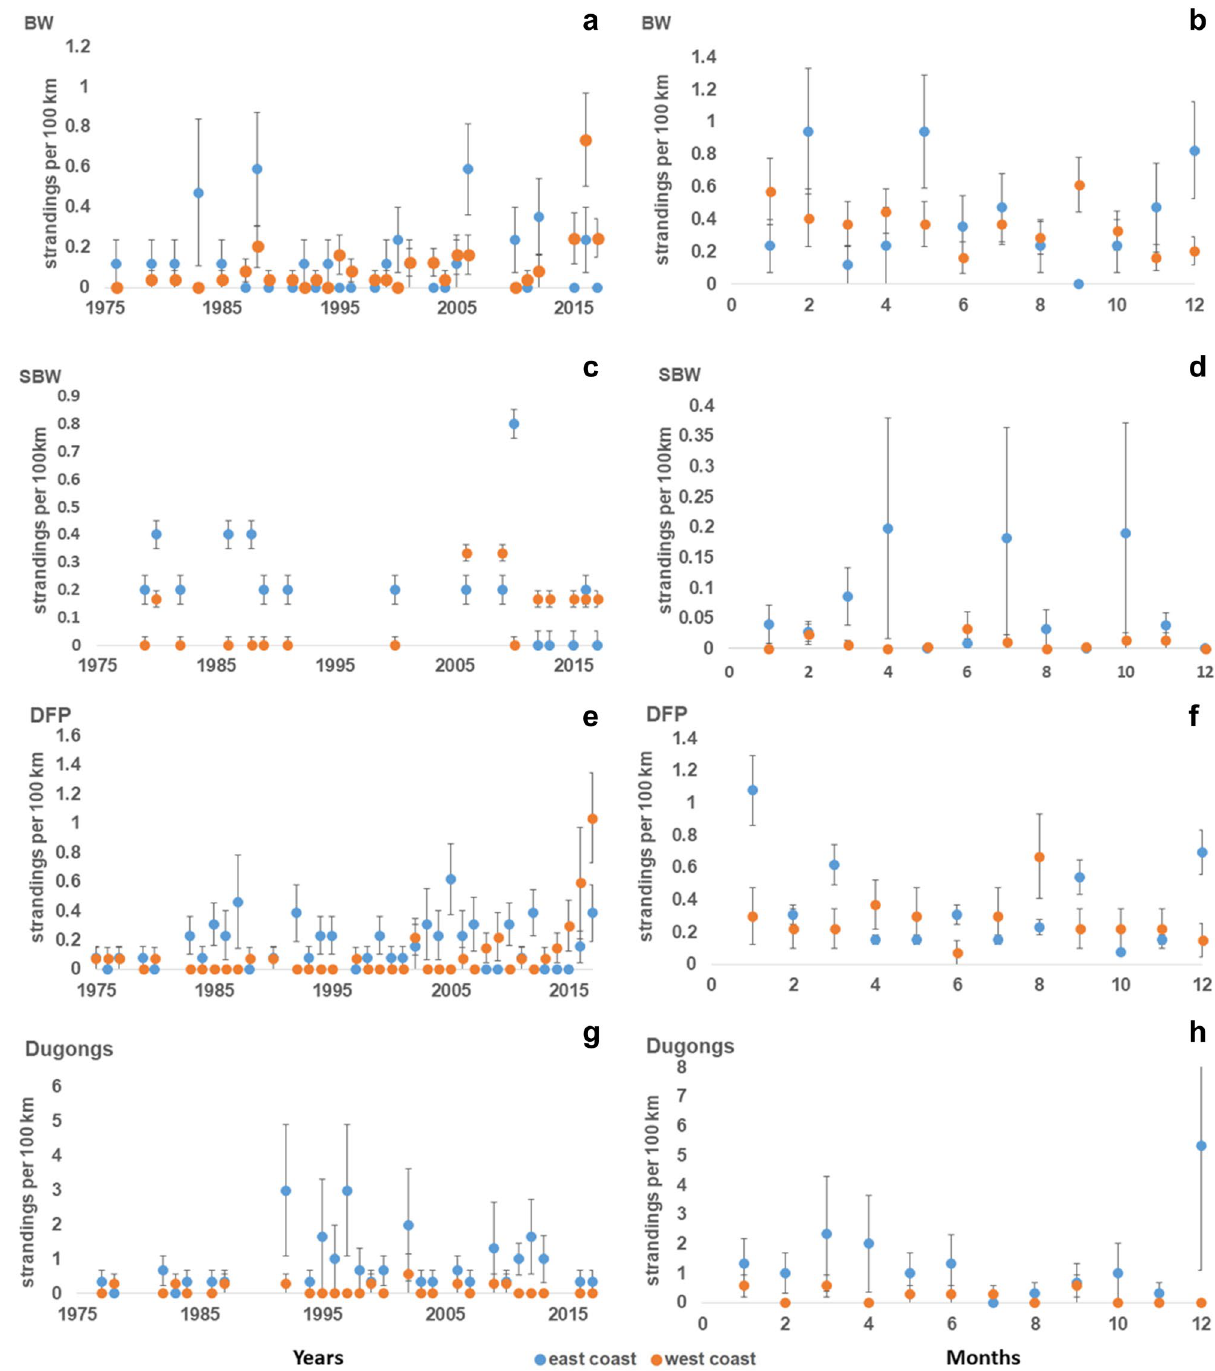
Figure 5. Temporal patterns (annual and monthly stranding rates / 100 km of coastline) in strandings of marine mammal records obtained from data compiled between years 1975–2017 along east and west coast of India for each group where ( a ) annual stranding rate and ( b ) monthly stranding rate for baleen whales (BW); ( c ) annual stranding rate and ( d ) monthly stranding rate for dolphins and finless porpoise (DFP); ( e ) annual stranding rate and ( f ) monthly stranding rate for sperm and beaked whales (SBW) and ( g ) annual stranding rate and ( h ) monthly stranding rate for